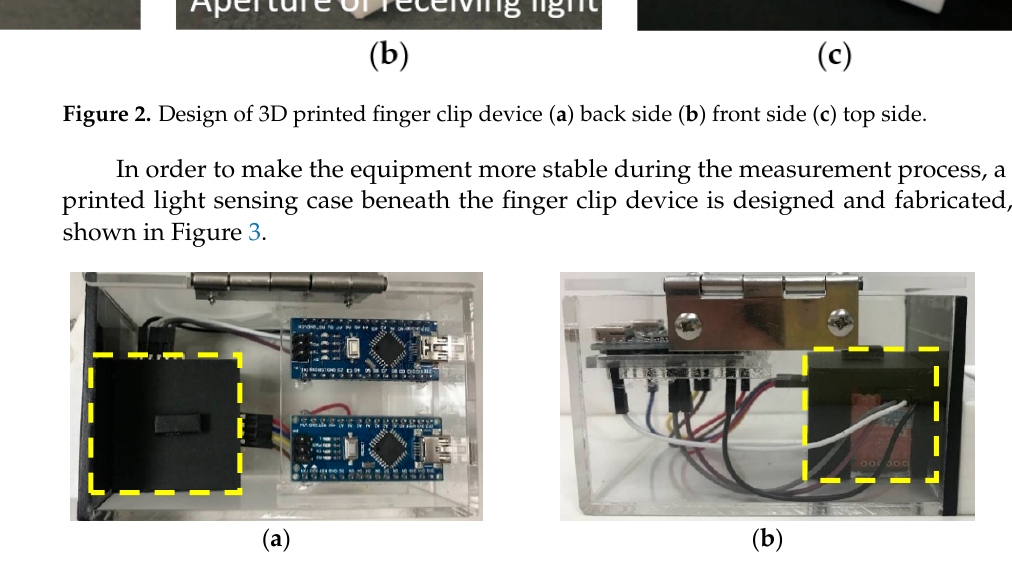
Figure 3. Design and assembly of 3D printed sensor light sensing case ( a ) top ( b ) back.